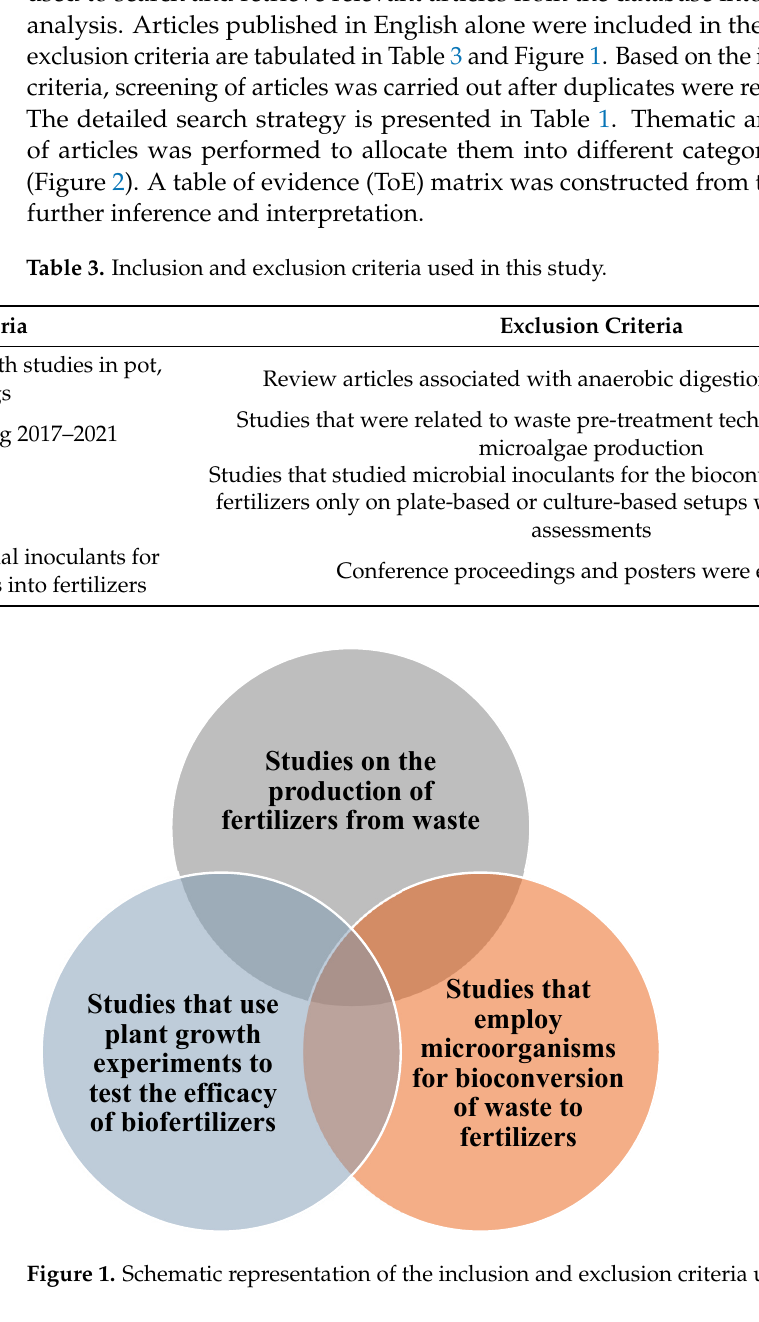
Figure 2. PRISMA flowchart reporting the article selection process for the systematic literature re- view.